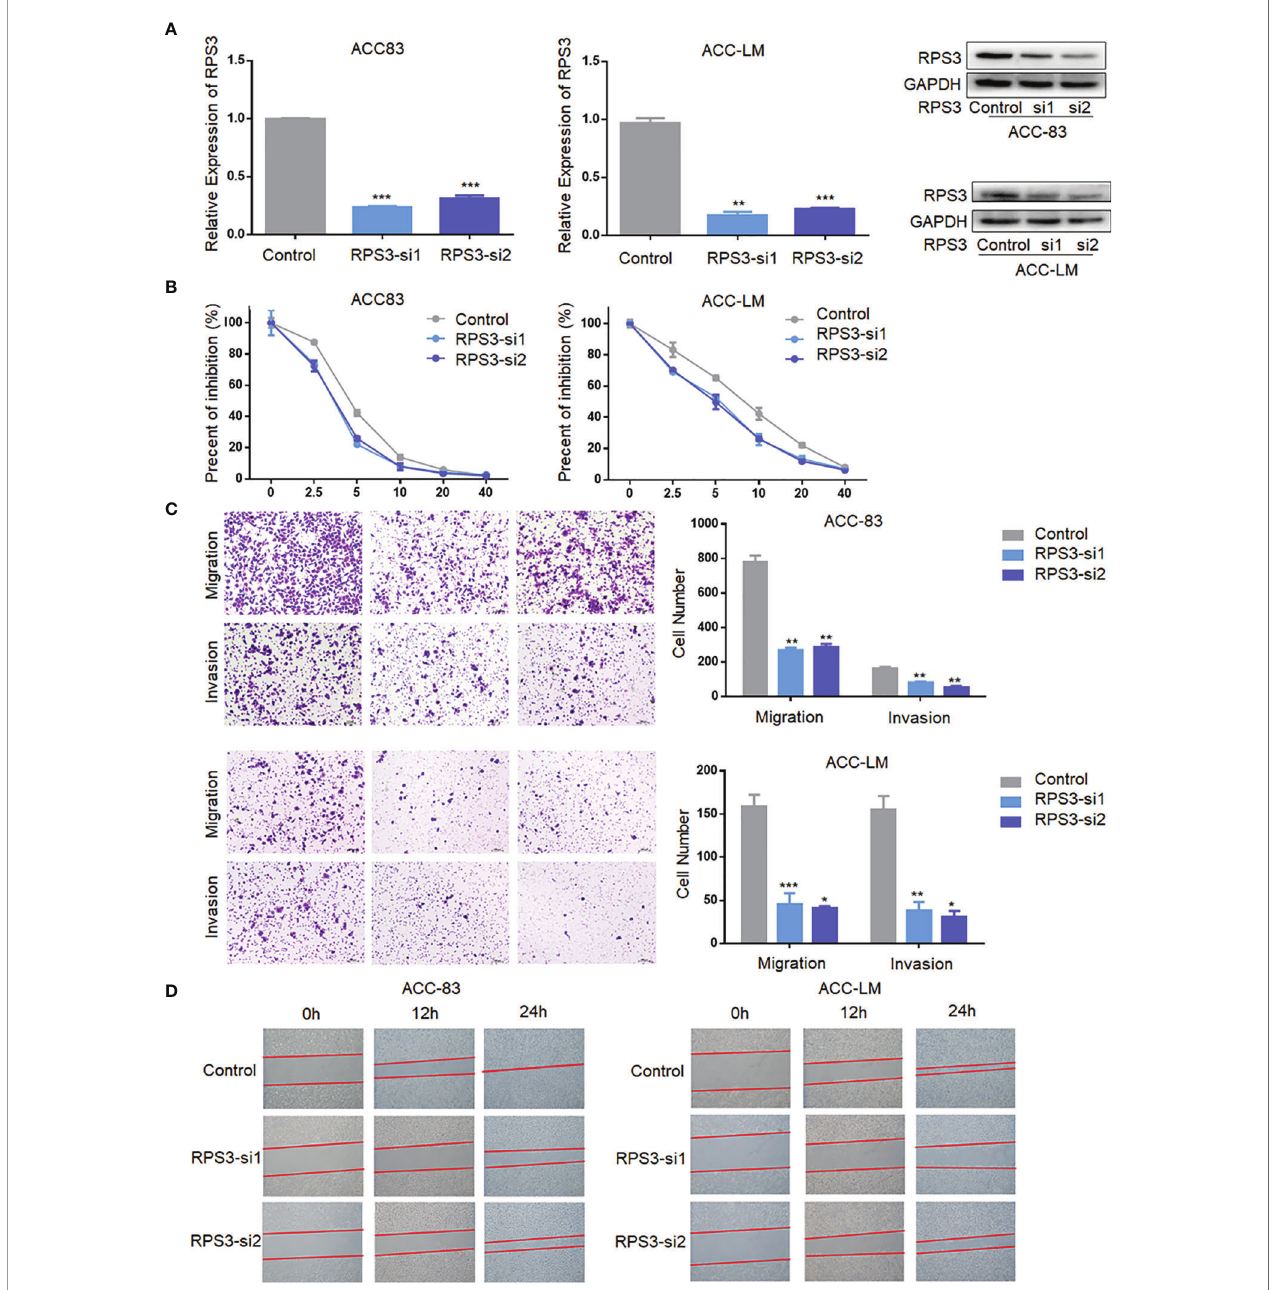
FIGURE 3 | Inhibition of RPS3 expression reduced ACC migration, invasion and cisplatin resistance. (A) qPCR and WB experiments showed that the mRNA and protein levels of RPS3 were decreased after transfection with siRNA in ACC-83 and ACC-LM cells. (B) The IC50 value showed cisplatin chemoresistance upon downregulation of RPS3. (C) ACC cell migration and invasion were inhibited upon downregulation of RPS3, according to the transwell assay. (D) ACC cell migration was inhibited upon downregulation of RPS3, according to the wound-healing assay. *P < 0.05; **P < 0.01; ***P <